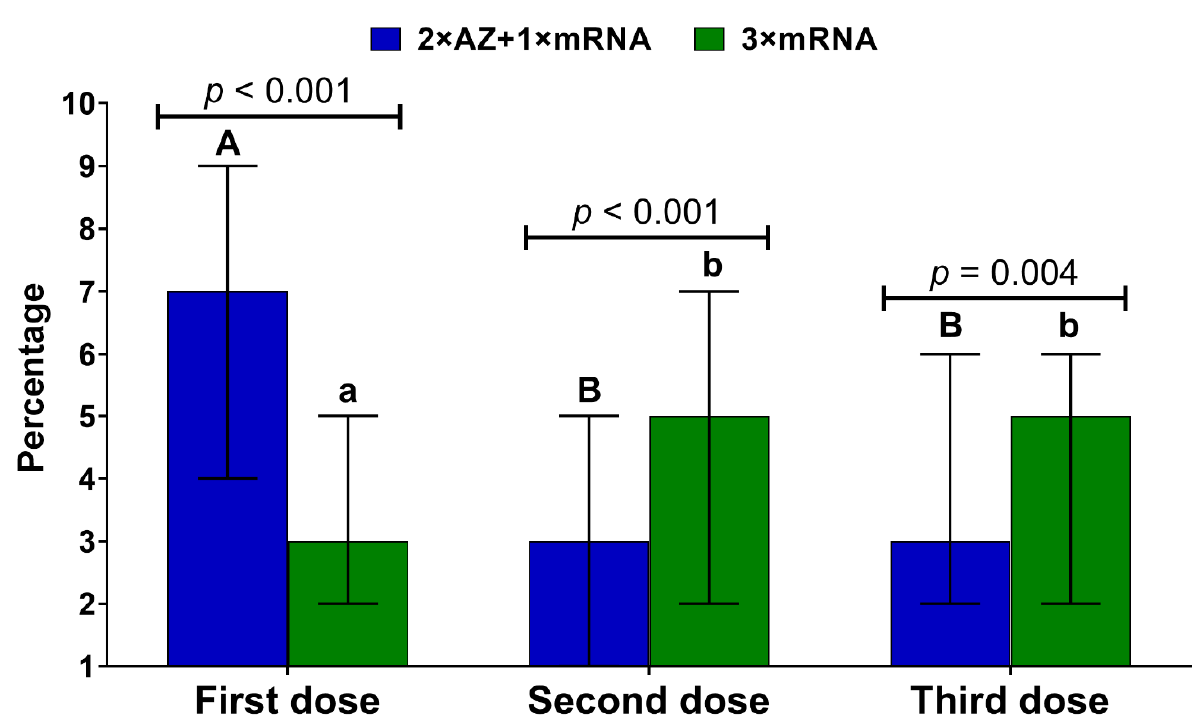
Figure 2. Side effects’ nuisance level (median and interquartile range) after each vaccine dose measured using a 10-point Likert scale in the homologous and heterologous groups. Different capital letters indicate a significant difference between particular doses in the 2 × AZ + 1 × mRNA group, while different small letters indicate a significant difference between specific doses in the 3 × mRNA group (Kruskal–Wallis ANOVA with Dunn’s post-hoc test).